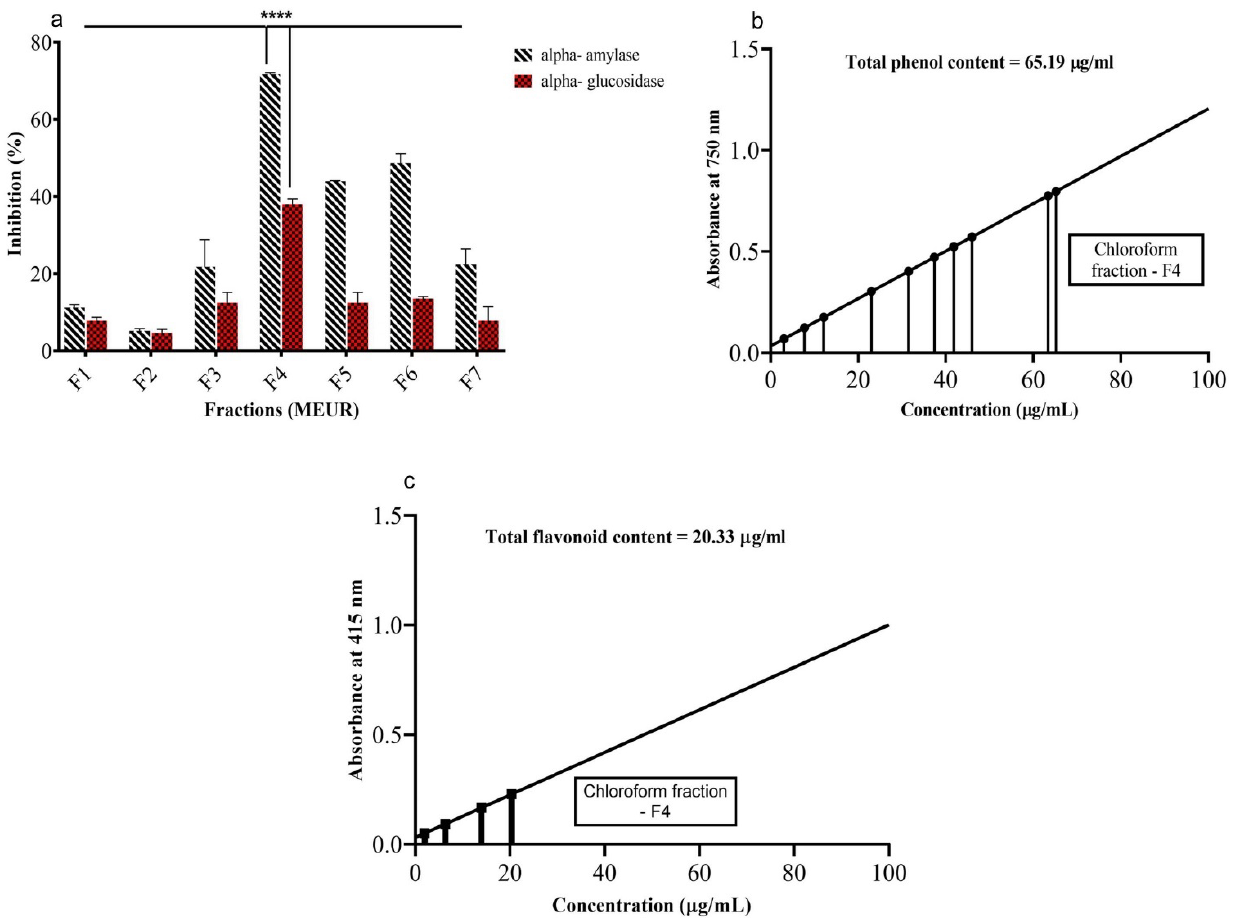
Figure 5. In vitro α -amylase, α -glucosidase inhibitory activity, and determination of total phenols and flavonoids of isolated fractions from MEUR. ( a ) In vitro α -amylase, α -glucosidase, ( b ) total phenols, and ( c ) flavonoids of various fractions of MEUR. Absorbance was measured at 540 nm ( α -amylase) and 405 nm ( α -glucosidase). Mean values were analyzed using two-way ANOVA (Tukey’s multiple comparisons test). **** p < 0.0001 considered as significant.